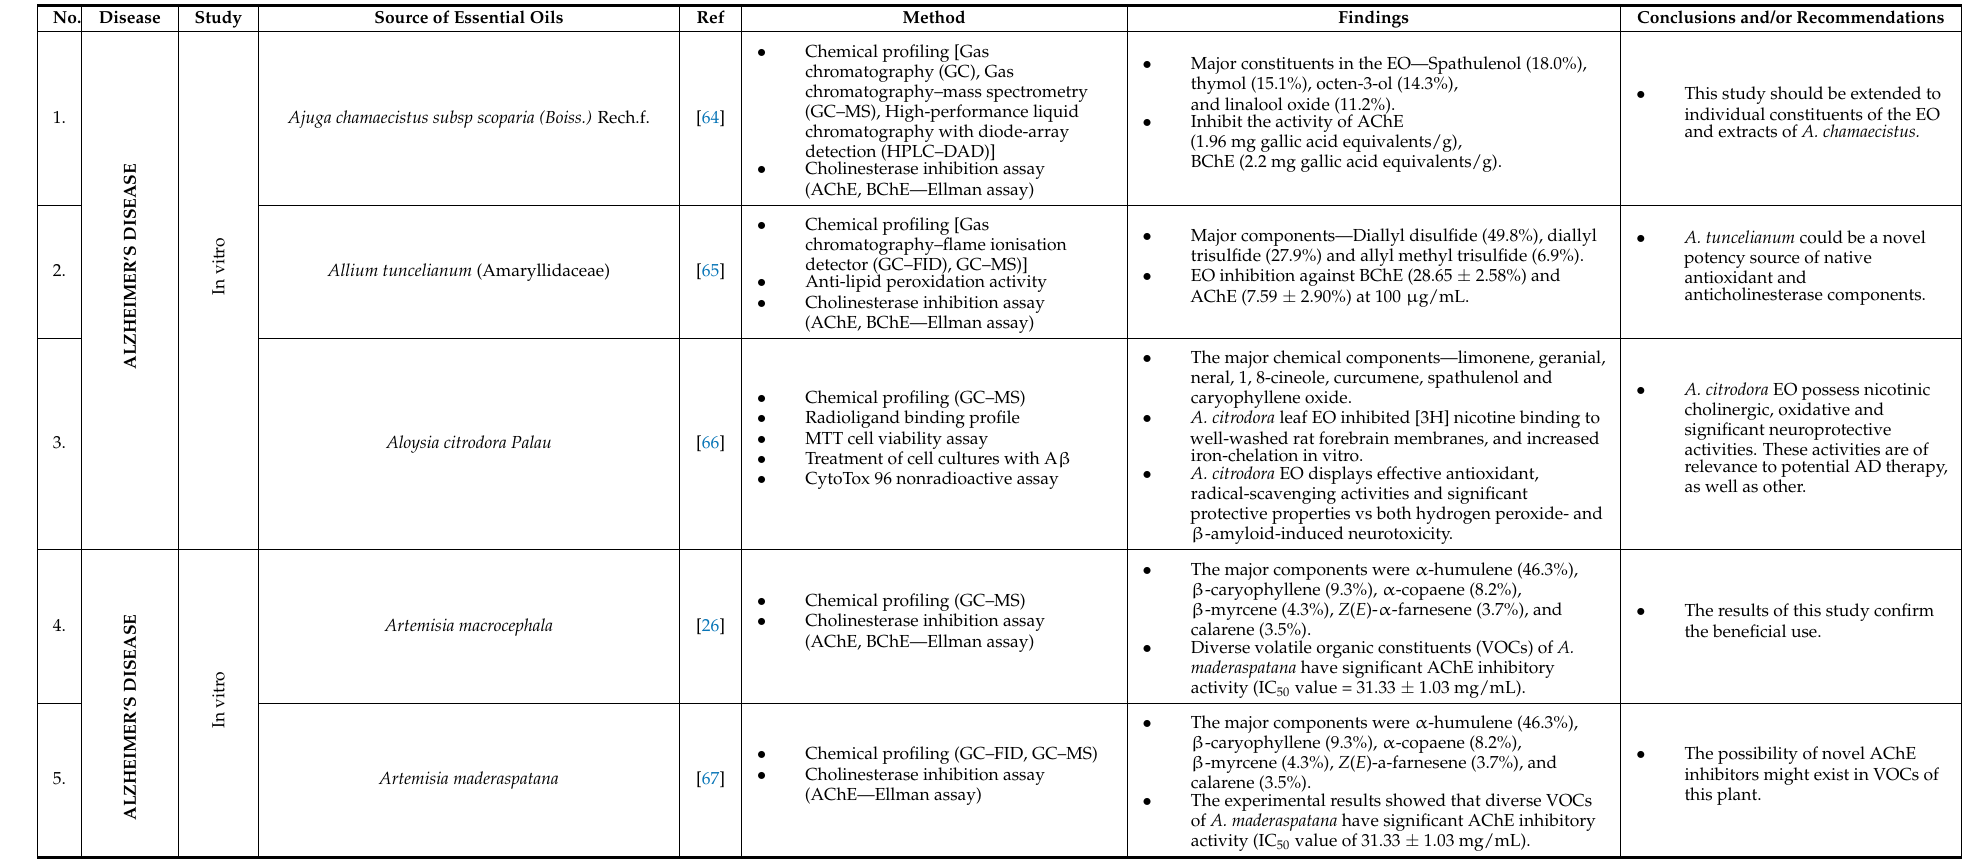
Table 1. Effects of essential oils (EOs) on neurodegenerative